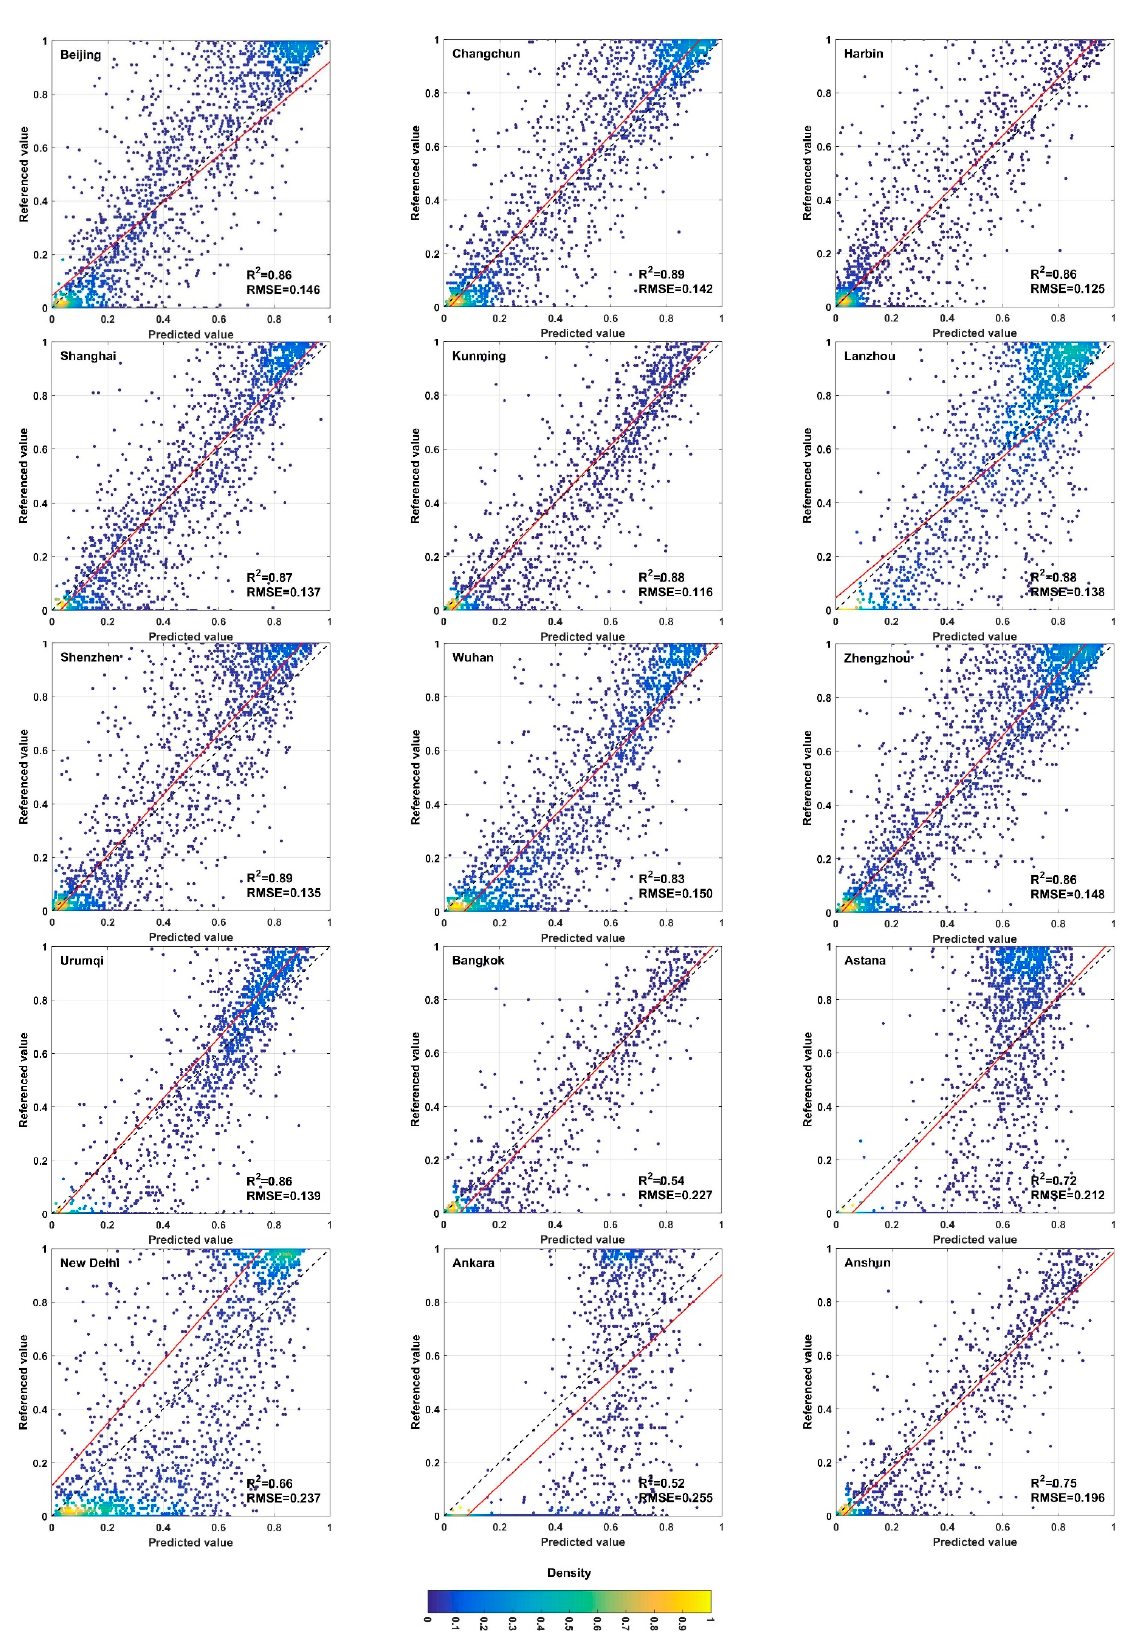
Figure 6. Scatterplots of predicted and reference values in typical cities in 2018. Values of predicted AISP derived from scheme 4 using 80% of samples as training in typical cities.